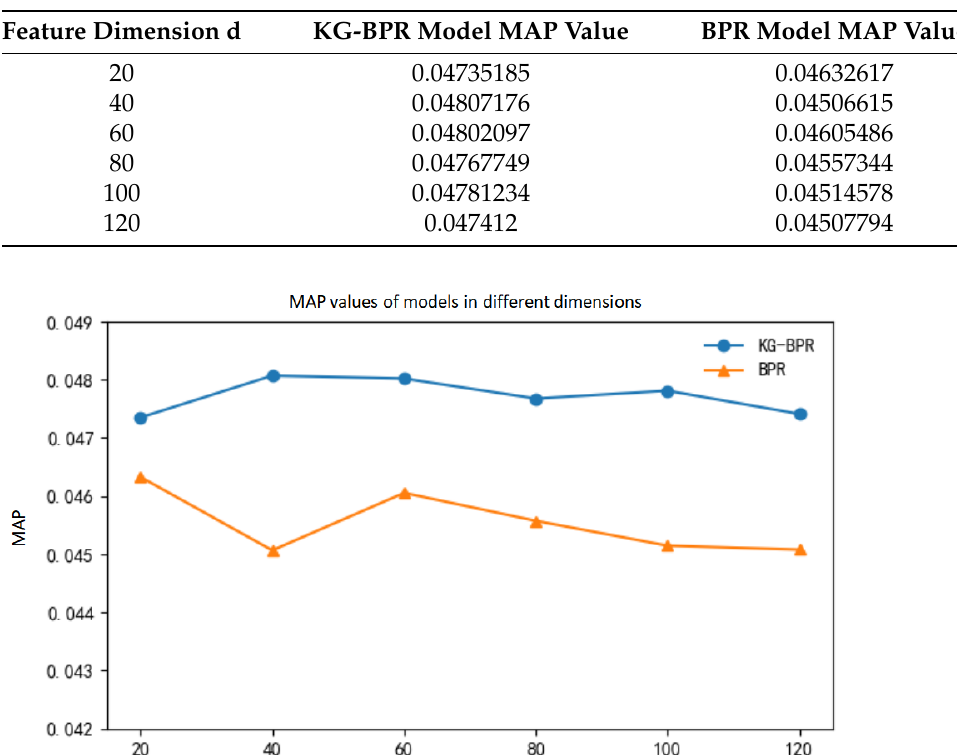
Table 4. MAP values of models in different dimensions.